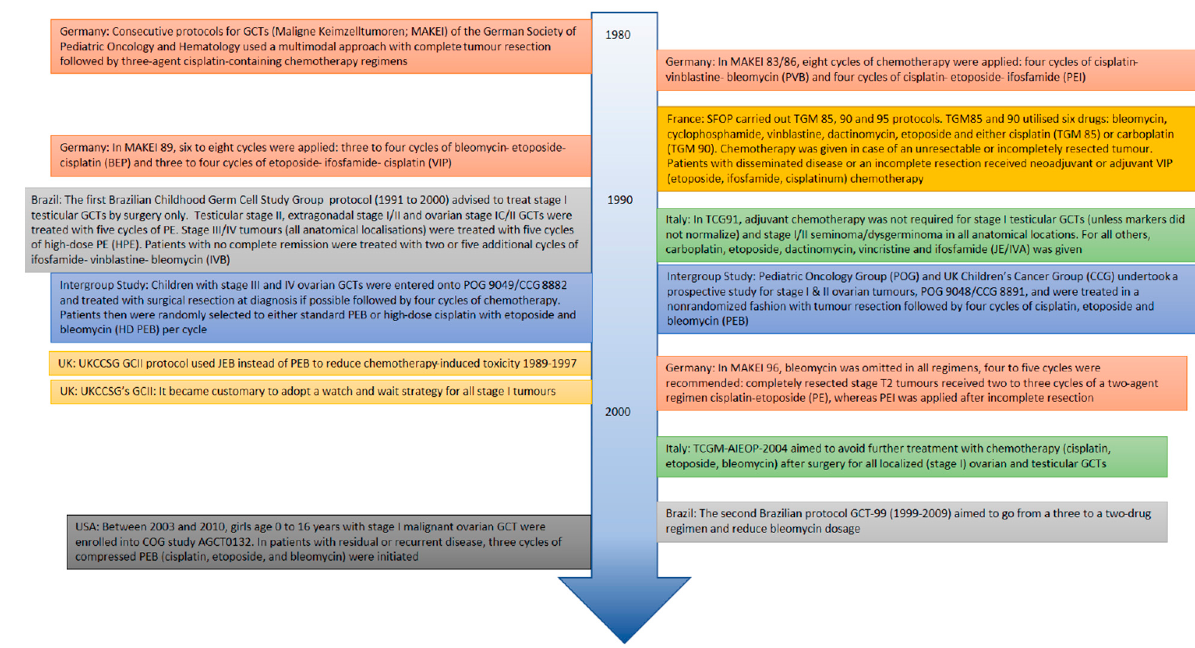
Figure 1. (inter)national protocols and intergroup studies over the past two decades.